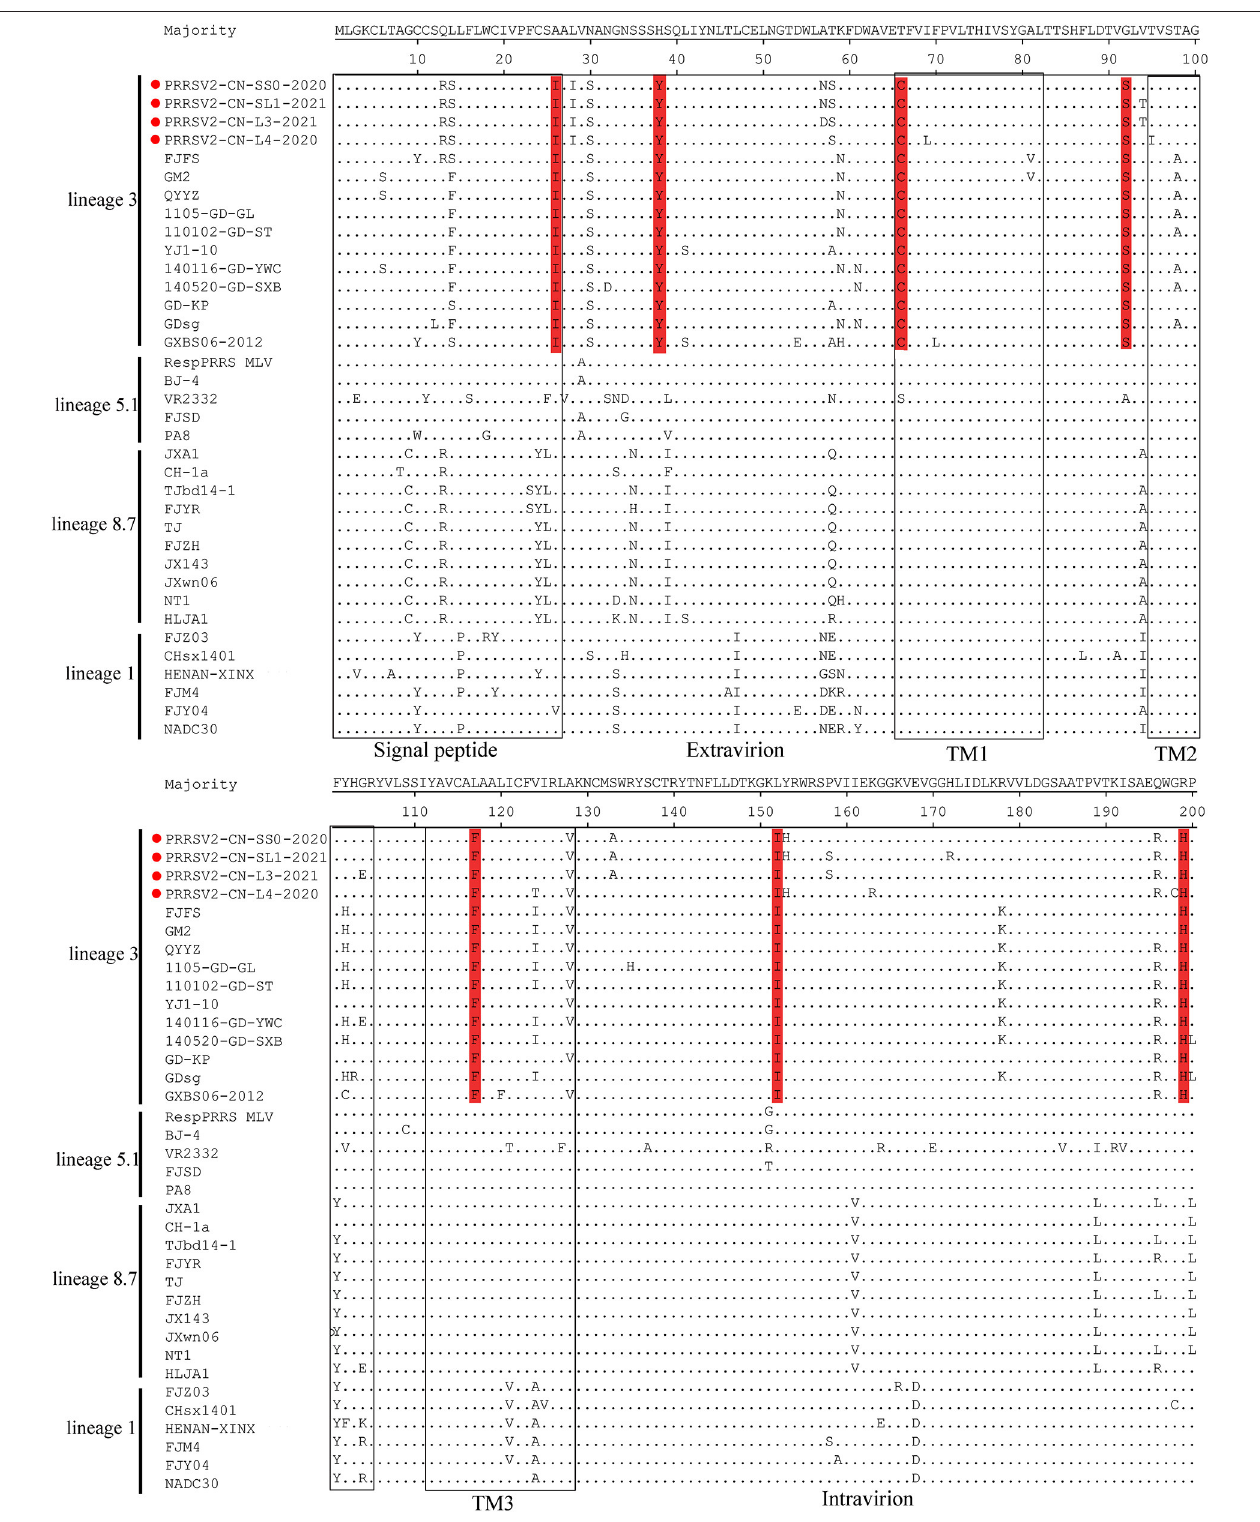
FIGURE 3 | Analysis and comparison of amino acid mutations in GP5 compared to reference viruses. The signal peptide and transmembrane (TM) domains in GP5 are highlighted by rectangles. Important amino acid changes between four strains (red cicrlce) and QYYZ-like PRRSVs in GP5 are indicated in red.